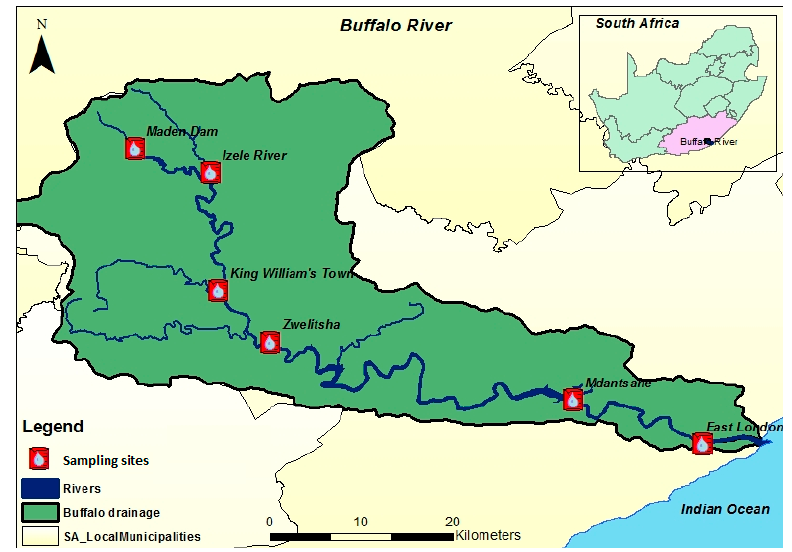
Figure 1. Map of Buffalo River showing the sampling sites for this study.